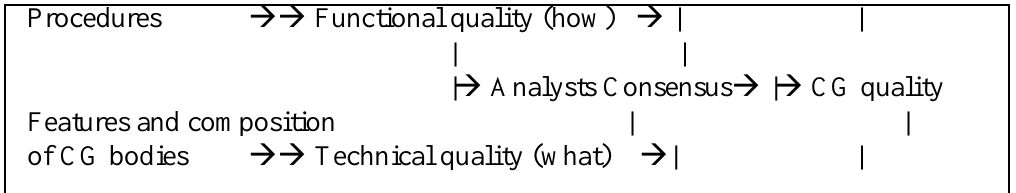
Figure 3.2 The Effect of Analysts Consensus on CG Quality Perception Procedures  Functional quality (how)  | | | | |  Analysts Consensus  |  CG quality Features and composition | | of CG bodies  Technical quality (what)  | | Source: Grönroos (1990), with